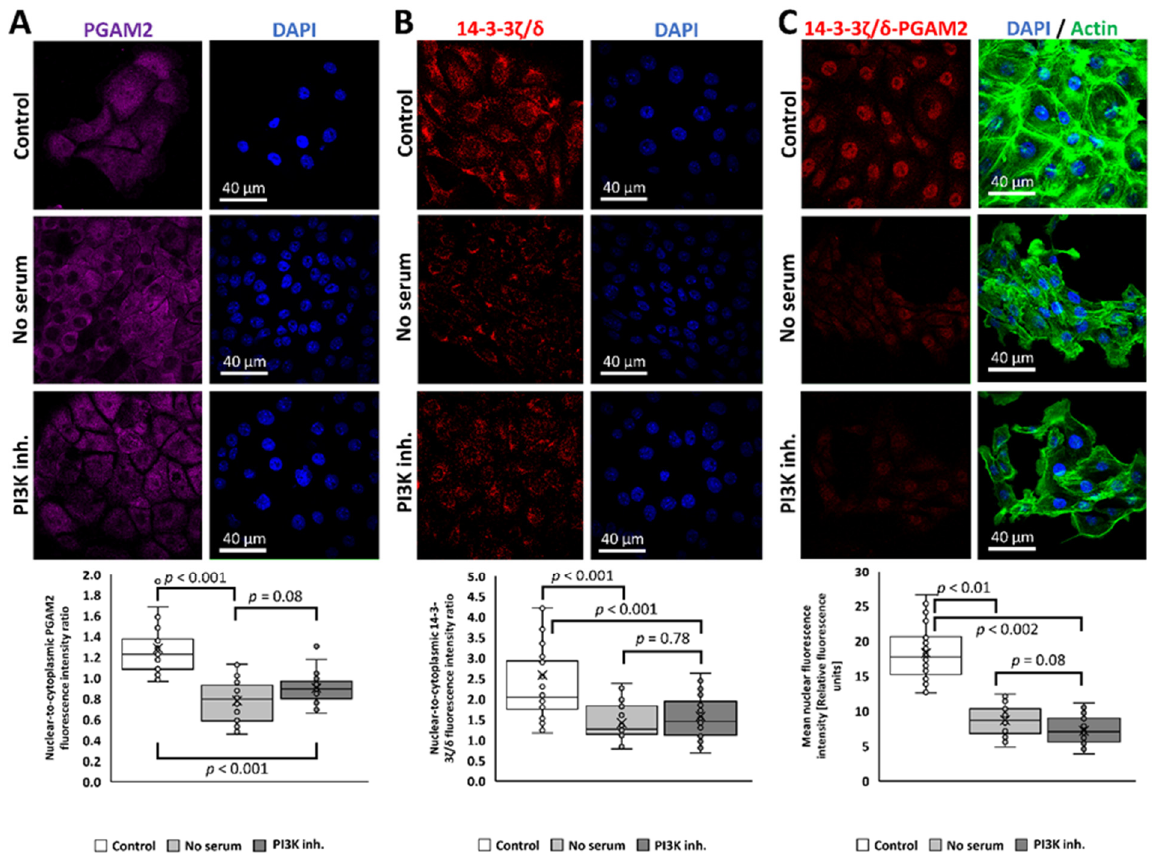
Figure 6. 14-3-3 ζ / δ –PGAM2 interaction depends on the insulin/IGF1–PI3K signaling pathway. PGAM2 ( A ) and 14-3-3 ζ / δ ( B ) are not present in the nucleus when cells are cultured in serum-depleted medium or in the presence of PI3K inhibitor, wortmannin. Similarly, the interaction between these proteins ( C ) is almost completely abolished in the above conditions.